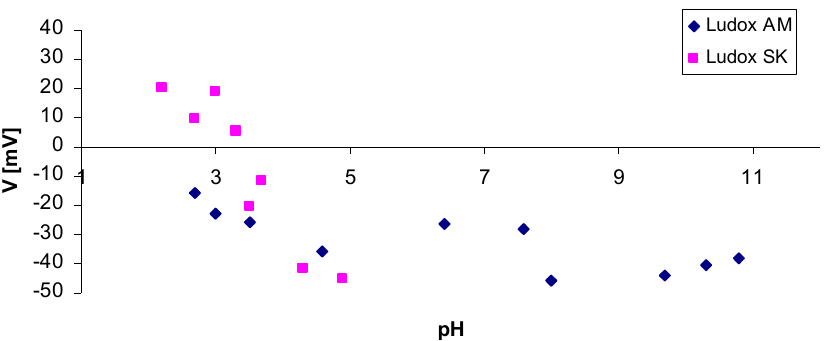
Figure 12. Dependence of the zeta potential on pH for Ludox SK and Ludox AM binders used to produce the first layer of a ceramic mould.